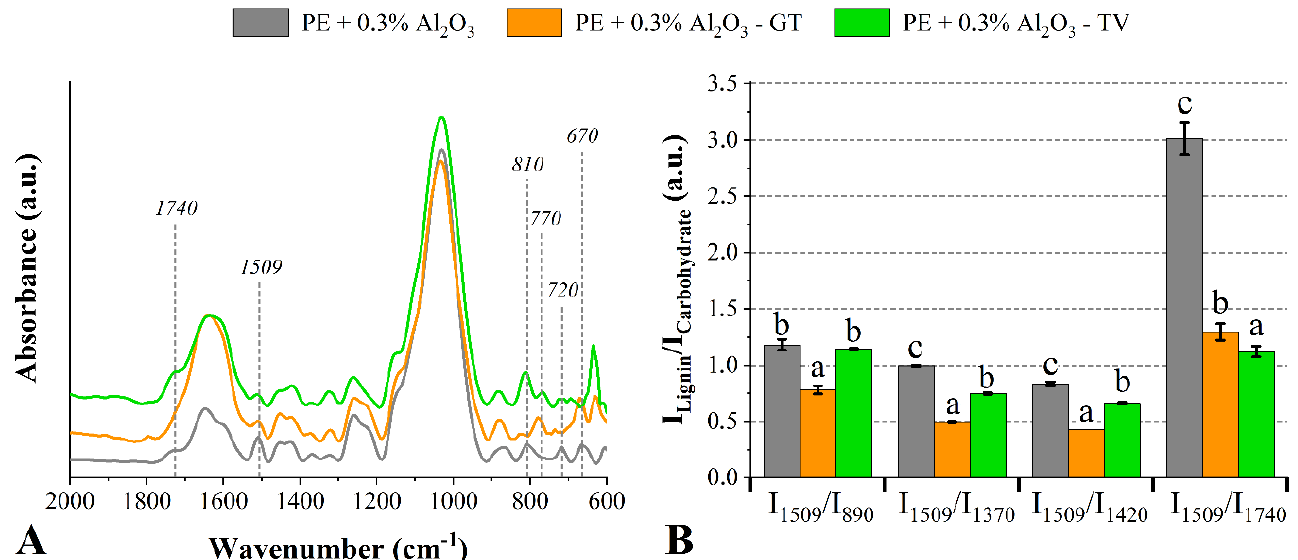
Figure 4. FT − IR spectra ( A ) and lignin/carbohydrate ratios ( B ) of the P. elliottii (P E ) woods treated with 0.3% of Al 2 O 3 exposed to the G. trabeum and T. versicolor fungi. Where: Different letters above the bars indicate statistically different means for each lignin/carbohydrate ratio.